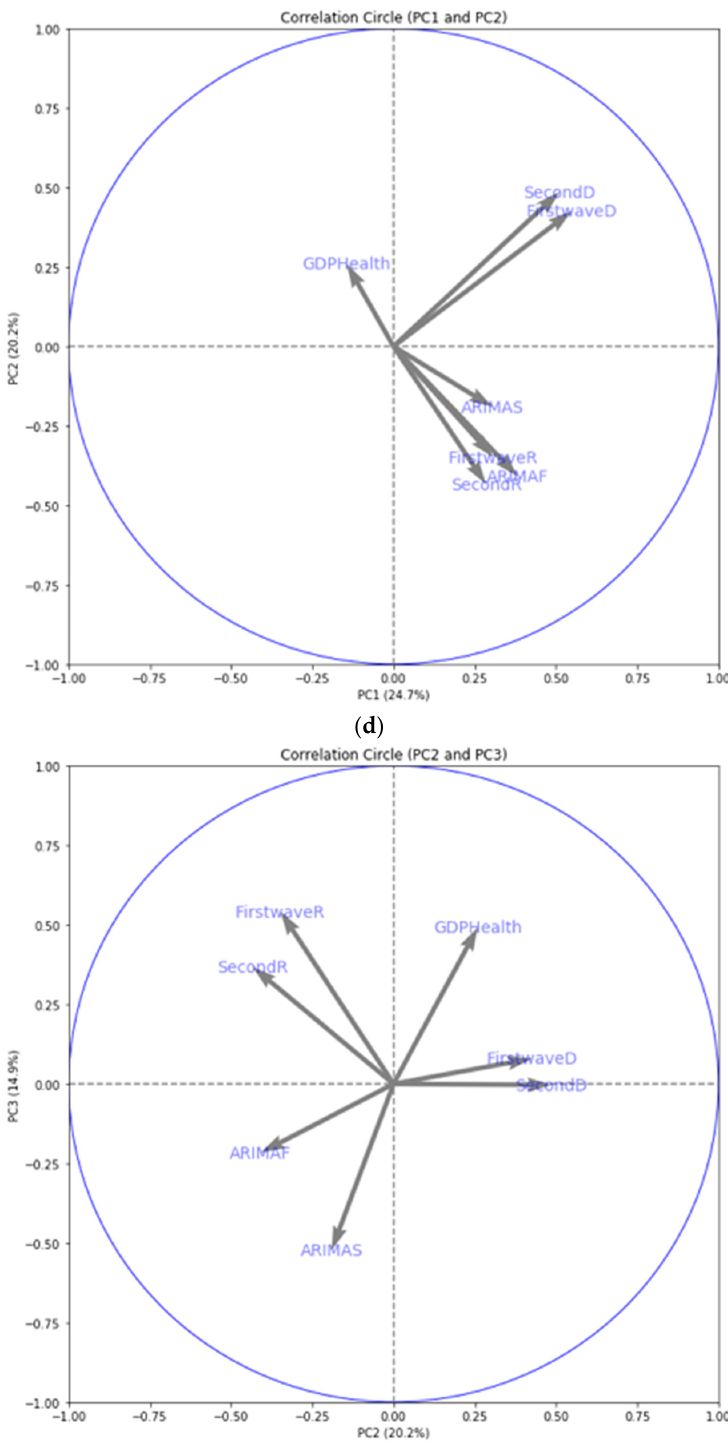
Figure 11. (a) Principal components (PC) plot from the principal component analysis (PCA) on the initial variables: first and second waves maximum R 0 , first wave R 0 and second wave R 0 , deterministic R 0 , first wR 0det and second wR 0det , first Arima slope, second wave Arima slope, and CHE/GDP. ( b ) Projection of the points corresponding to 204 countries of the PCA’s plot on the first PC plane with more developed countries in green and more developing in orange. ( c ) Explained variance plot. ( d , e ) Correlation circles for the two first PC planes.